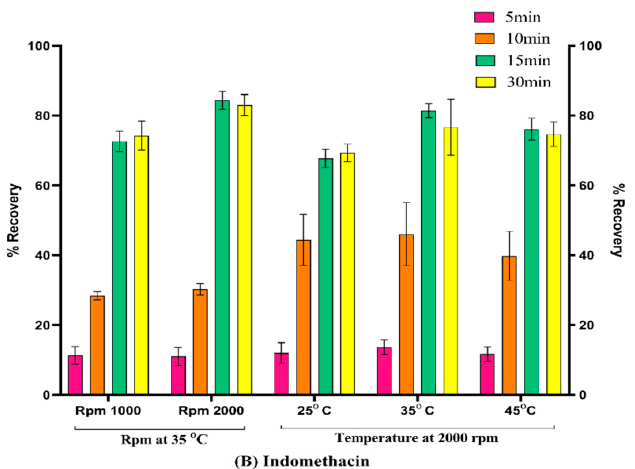
Figure 6. Optimization of extraction recovery of ( A ) acetaminophen and ( B ) indomethacin by using RPM and temperature.